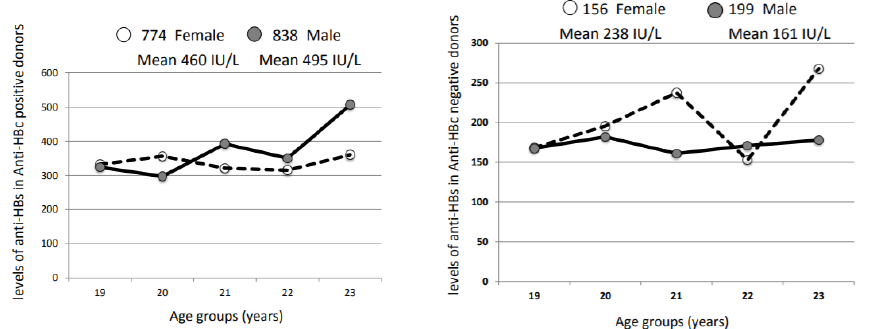
Figure 4. Distribution of median anti-HBs levels in presumably vaccinated Chinese blood donors 18–21 years old and non-vaccinated (22–25 years) associated or not with anti-HBc. Open circles and dotted line indicate female data; grey circles and solid line indicate male data. The numbers above graphs indicate donors in each age group for males and females.